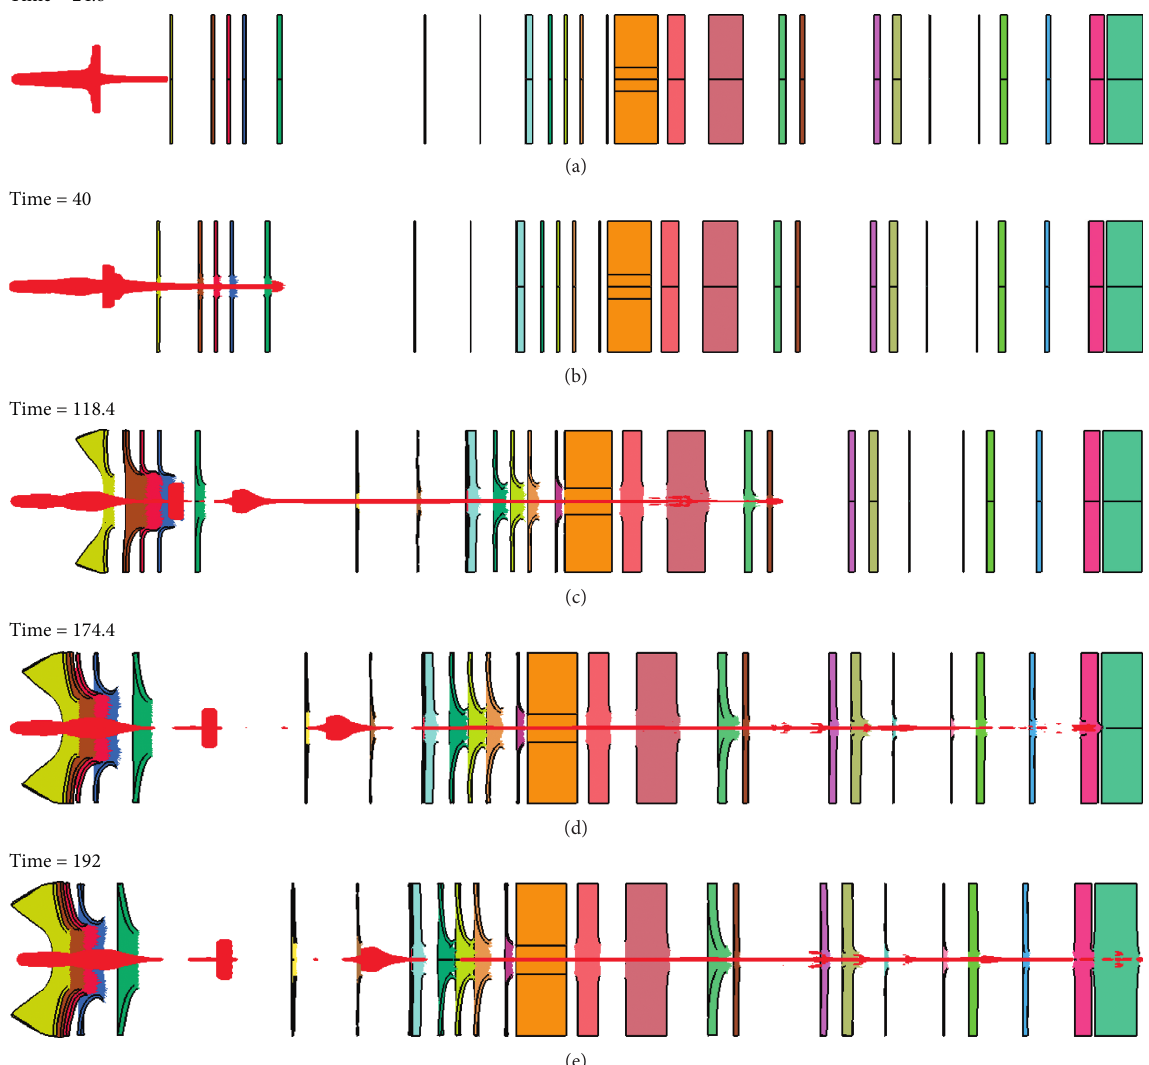
Figure 7: Penetration results of jet formed when liner material is steel: (a) the SCJ at observation point 1; (b) the SCJ at observation point 2; (c) the SCJ at observation point 3; (d) the SCJ at observation point 4; (e) the SCJ at observation point 5.